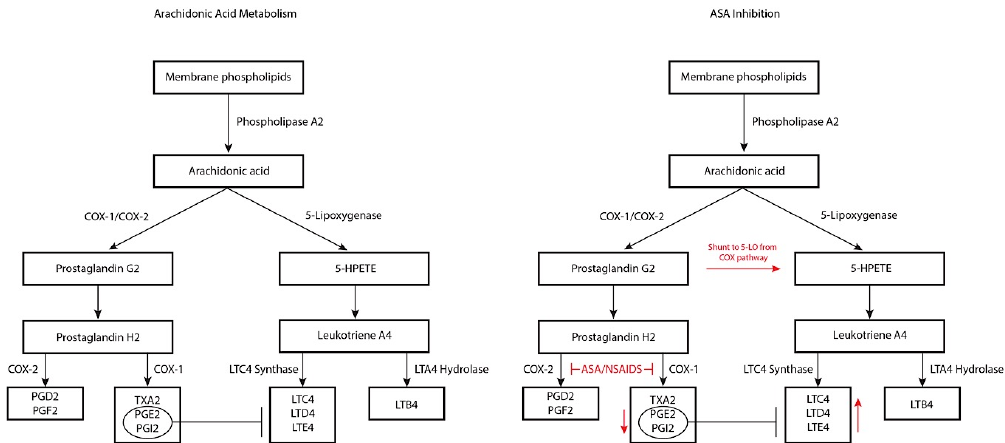
Figure 1. Arachidonic acid pathway ( left panel ) with associated impact of aspirin/non-steroidal anti- inflammatory disease (NSAID) therapy and inhibition ( right panel ). COX-1/2 – cyclooxygenase 1/2; PGD2 – prostaglandin D2; PGE2 – prostaglandin E2; PGF2 – prostaglandin F2; PGG2 – prostaglandin G2; PGH2 – prostaglandin H2; PGI2 – prostaglandin I2; TXA2 – thromboxane A2; 5-HPETE – 5- hydroxyeicosatetranoic acid; LTA4 – leukotriene A4; LTB4 – leukotriene B4; LTC4 – leukotriene C4;